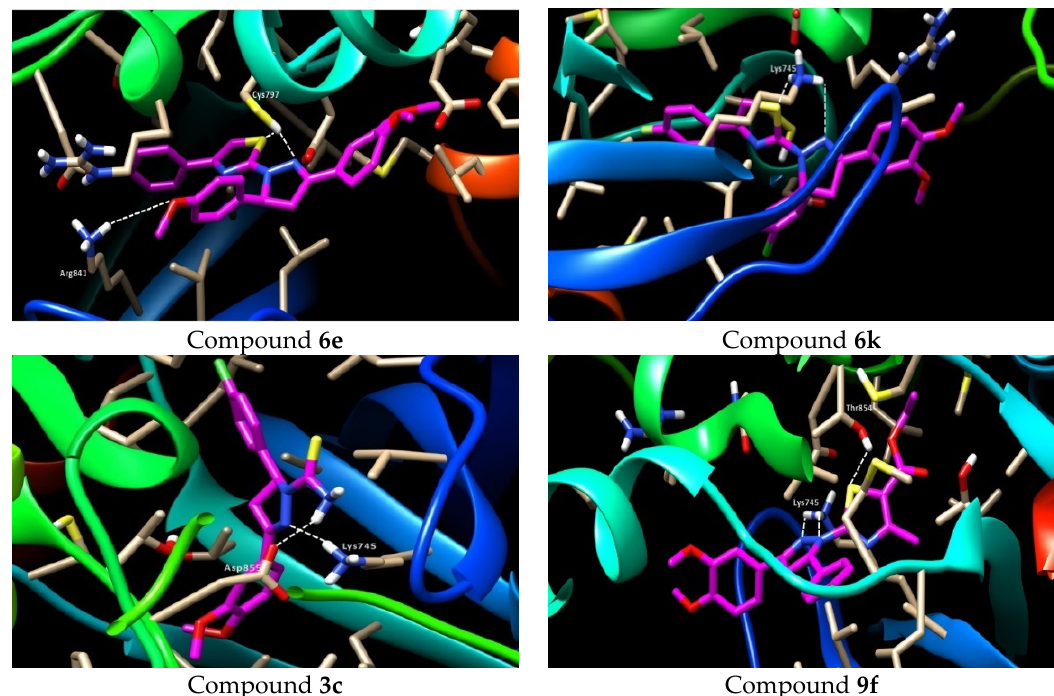
Figure 10. Binding interactions of the promising derivatives ( 6e , 6k , 3c , and 9f ) in the EGFR receptor (1XKK) showing ligands (magenta) and H bonds (white-dashed).